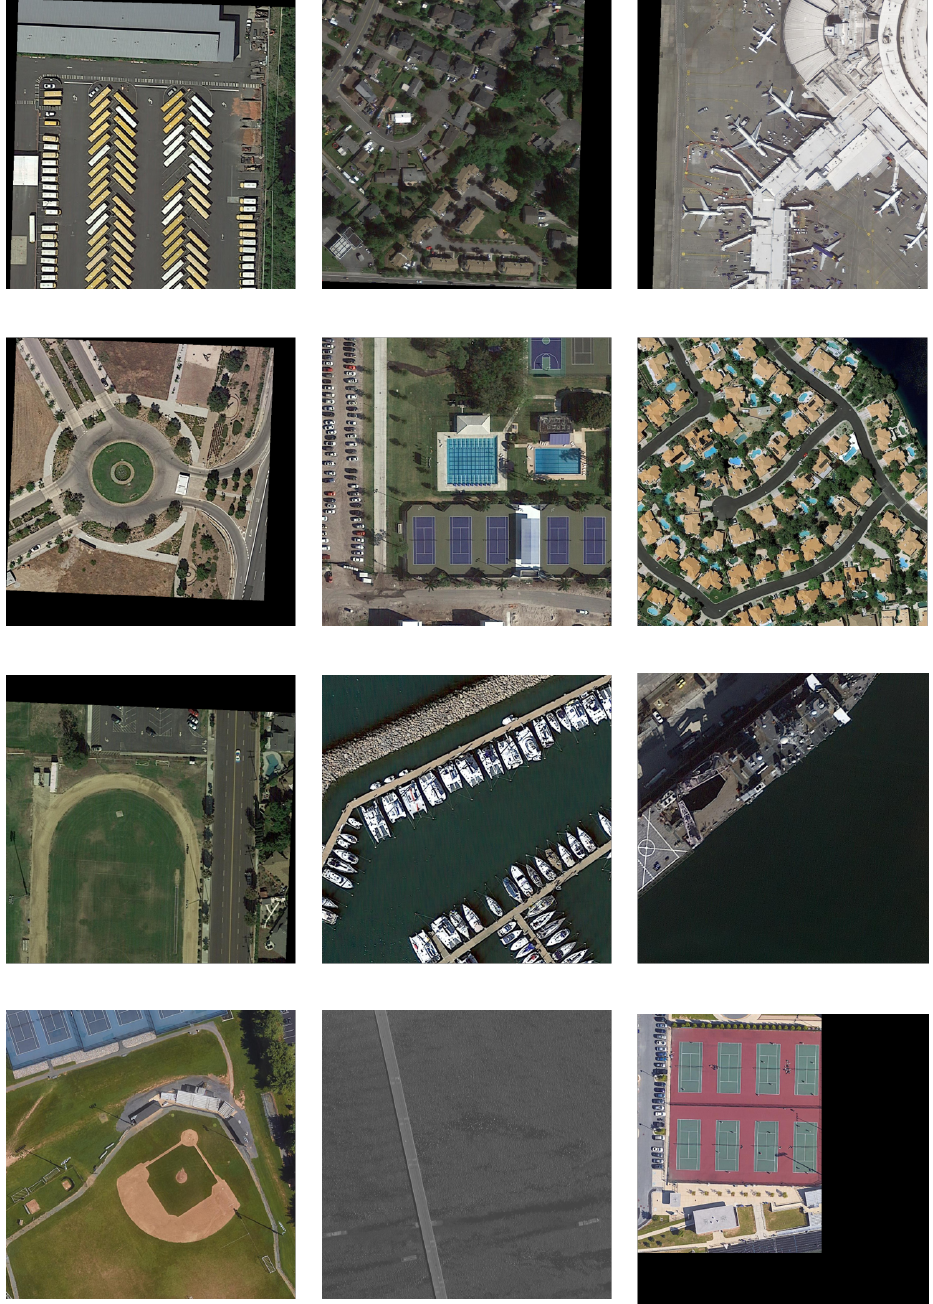
Figure 4. Sample aerial image patches with different scenes. The sizes of patches are all 1024 × 1024. Different patches have different scene semantics, forming a potential semantic contrast with each other. There are also intra-class and inter-class scale differences for objects between different